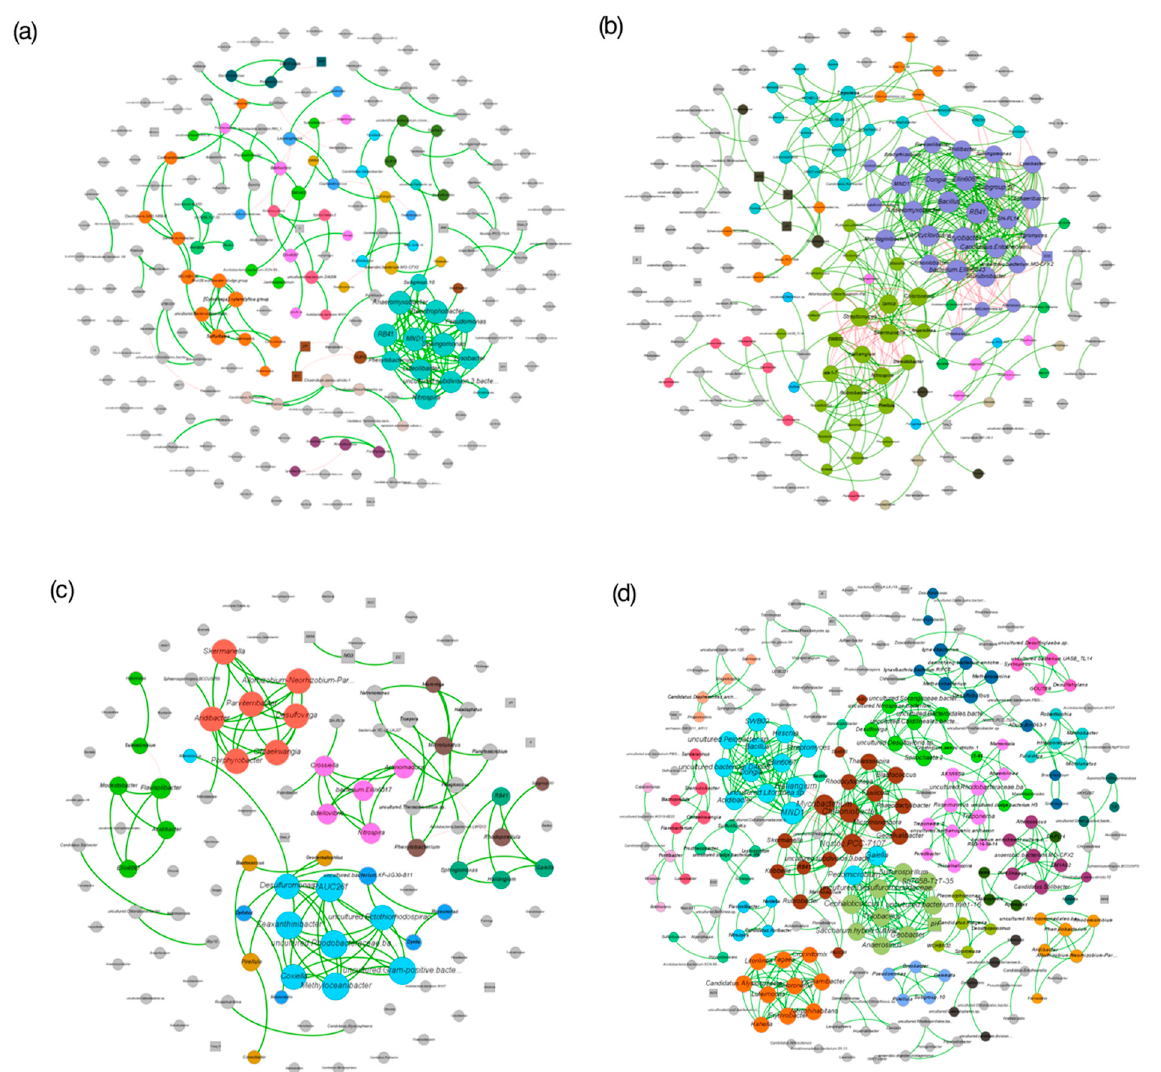
Figure 7. Co-occurrence network of bacterial communities in rice-cultivated fields in Umbeluzi ( a ) and Chokwe ( b ) and in the fallow fields in Umbeluzi ( c ) and Chokwe ( d ). The nodes represent bacterial genera or environmental variables and are colored according to modules. Nodes with <3 connections are colored gray. The size of each node is proportional to their betweenness centrality. The connections (edges) stand for significant (FDR-adjusted p < 0.01) associations, while their sizes are proportional to ρ . Positive associations (edges) are colored green, while negative associations are colored red. Rectangles denote environmental variables, while ellipses denote bacteria